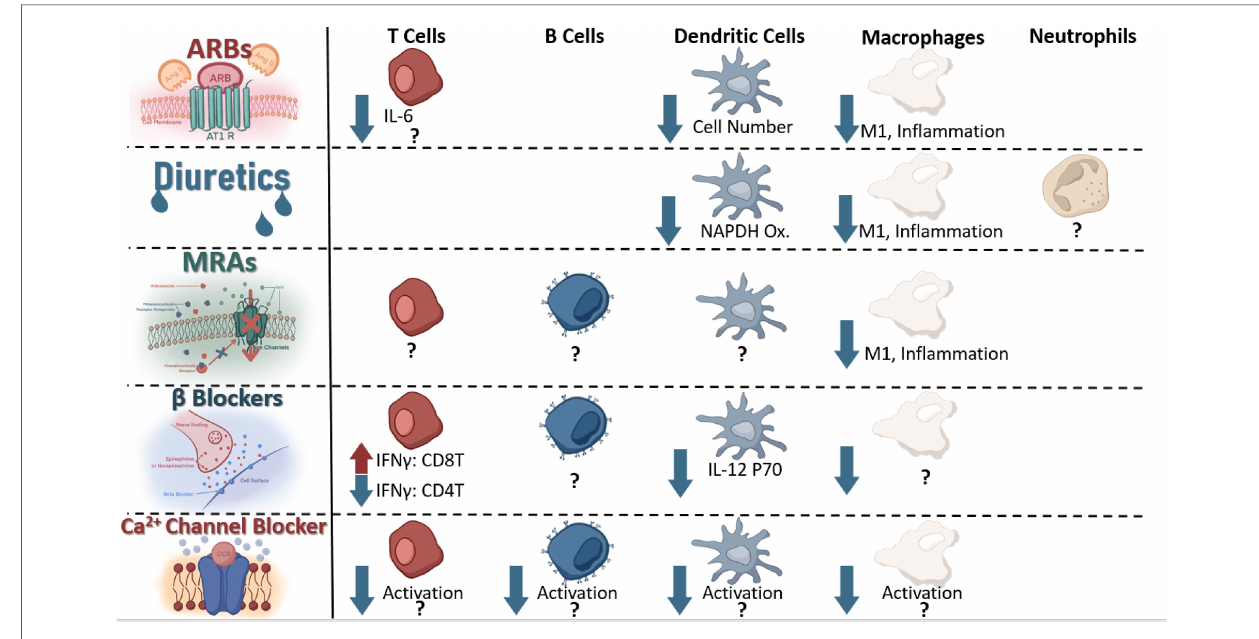
FIGURE 4 Immune cells known to express receptors antagonized by current antihypertensives and known change in signaling or function as a result of receptor